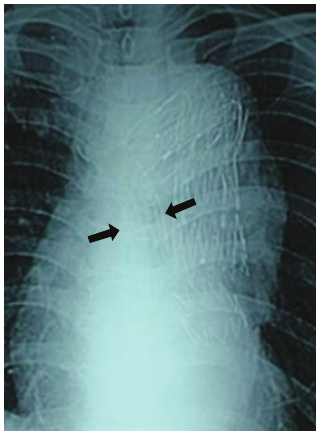
Figure 1: Esophageal endoscopy on hospital day five showed an esophageal ulceration with the prosthetic aortic graft visible at the base.